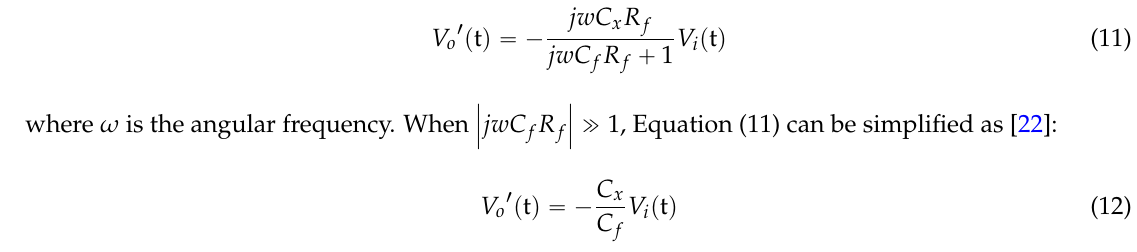
Figure 10. The C/V circuit.